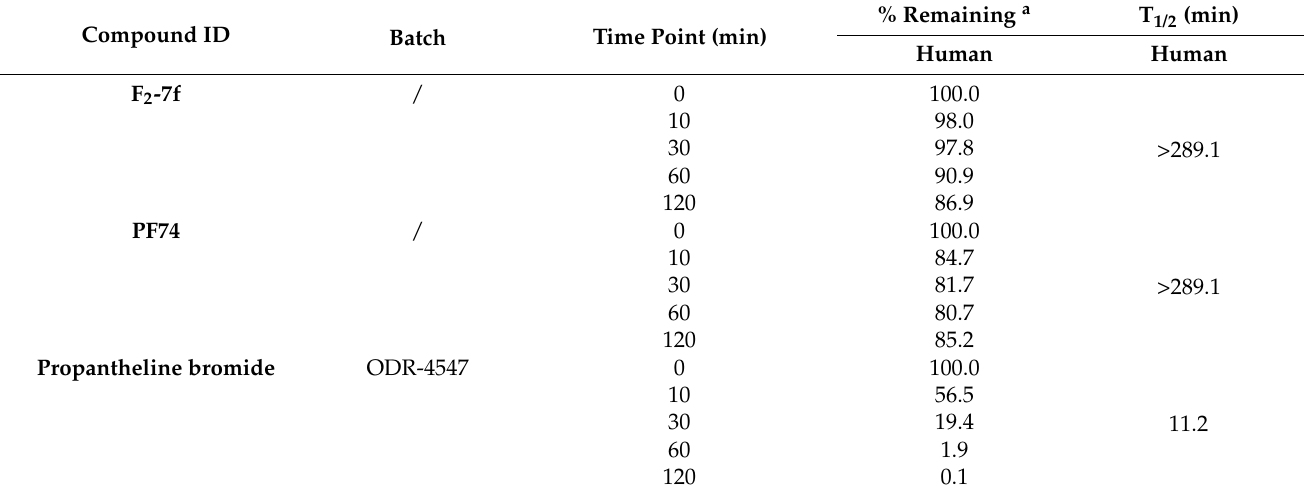
Table 5. Result of human plasma stability